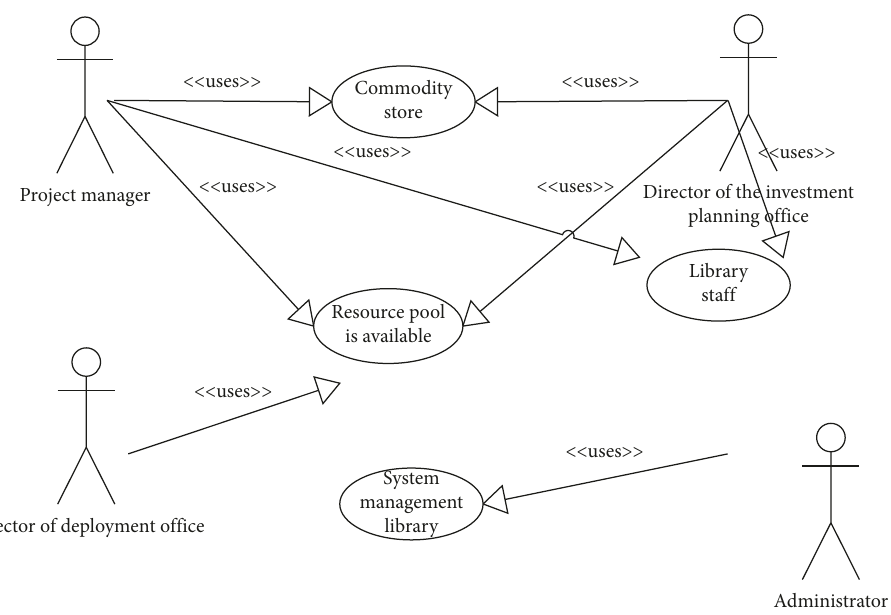
Figure 1: Overall system use case